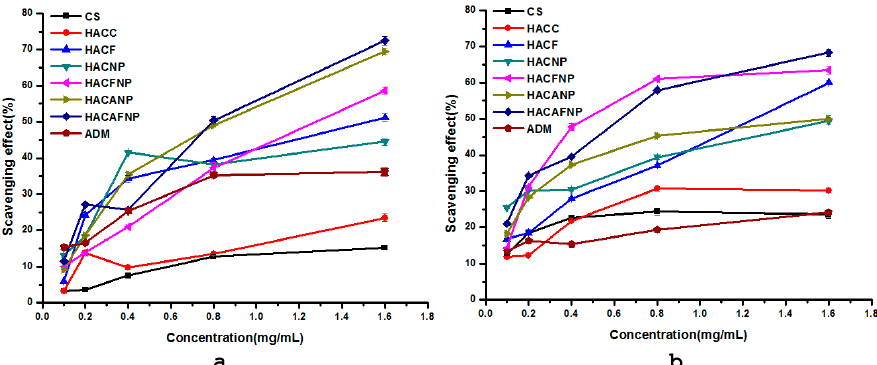
Figure 7. Superoxide radical scavenging activity ( a ) and DPPH radical scavenging ability ( b ) of chitosan, chitosan derivatives, and chitosan nanoparticles. Data are presented as mean value ± SD.